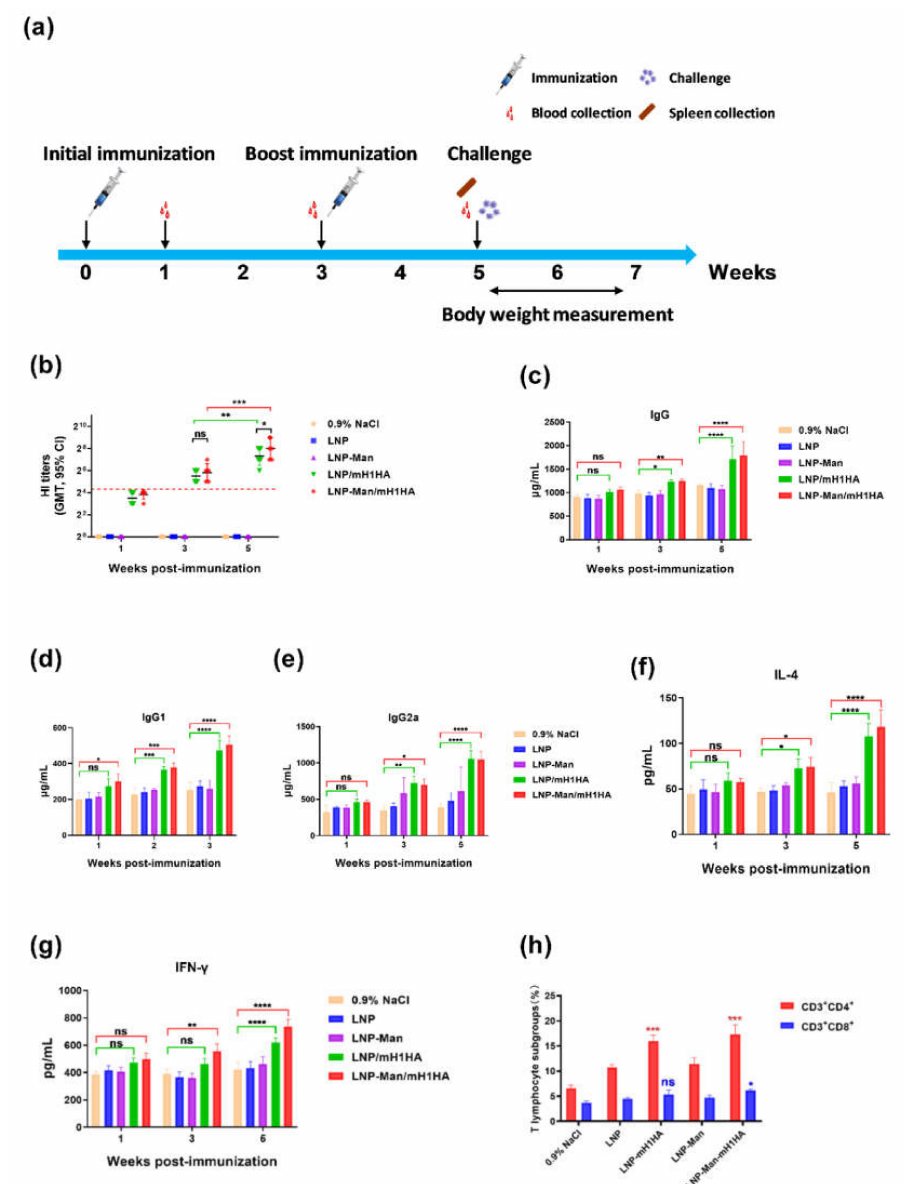
Figure 5. Immune responses in mice induced by LNPs / mH1HA vaccines. Serum samples were collected in the first, third, and fifth weeks after the initial immunization. ( a ) The flow chart of the animal experiment. ( b ) Hemagglutination inhibition (HI) assay. Data are shown as the geometric mean with 95% CI and were analyzed by two-way ANOVA ( n = 6, ns p > 0.05; ** p < 0.01; *** p < 0.001). ( c–e ) Total IgG / IgG1 / IgG2a levels in the serum were detected using ELISA kits. Data are shown as means ± SDs and were analyzed by two-way ANOVA ( n = 3, ns p > 0.05; * p < 0.05; ** p < 0.01; *** p < 0.001; **** p < 0.0001). ( f,g ) The IL-4 and IFN- γ levels in sera were determined by ELISA. Data are shown as means ± SDs and were analyzed by two-way ANOVA ( n = 3, ns p > 0.05; ** p < 0.01; **** p < 0.0001). ( h ) The percentages of CD3 + CD4 + and CD3 + CD8 + T lymphocyte subgroups were tested by flow cytometry. Data are shown as means ± SDs and were analyzed by two-way ANOVA ( n = 3, ns p > 0.05; * p < 0.05; *** p < 0.0001, compared with the 0.9% NaCl